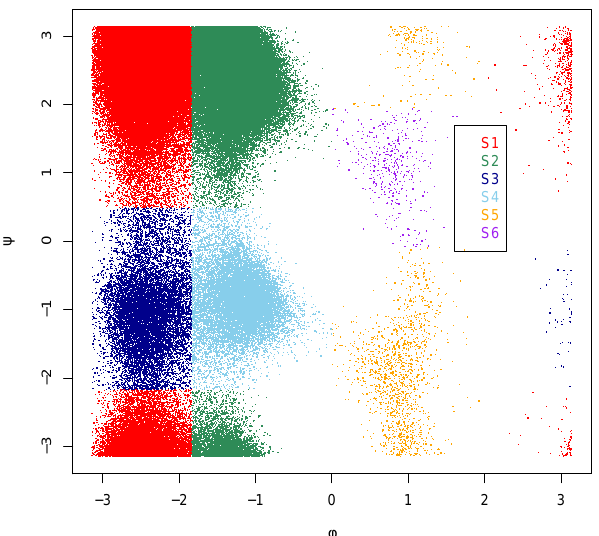
Figure 3. The scatter plot of φ - ψ of the alanine dipeptide with φ , ψ ∈ [ − π , π ] . The partition of φ - ψ space into six clusters follows that given in Chodera et al.